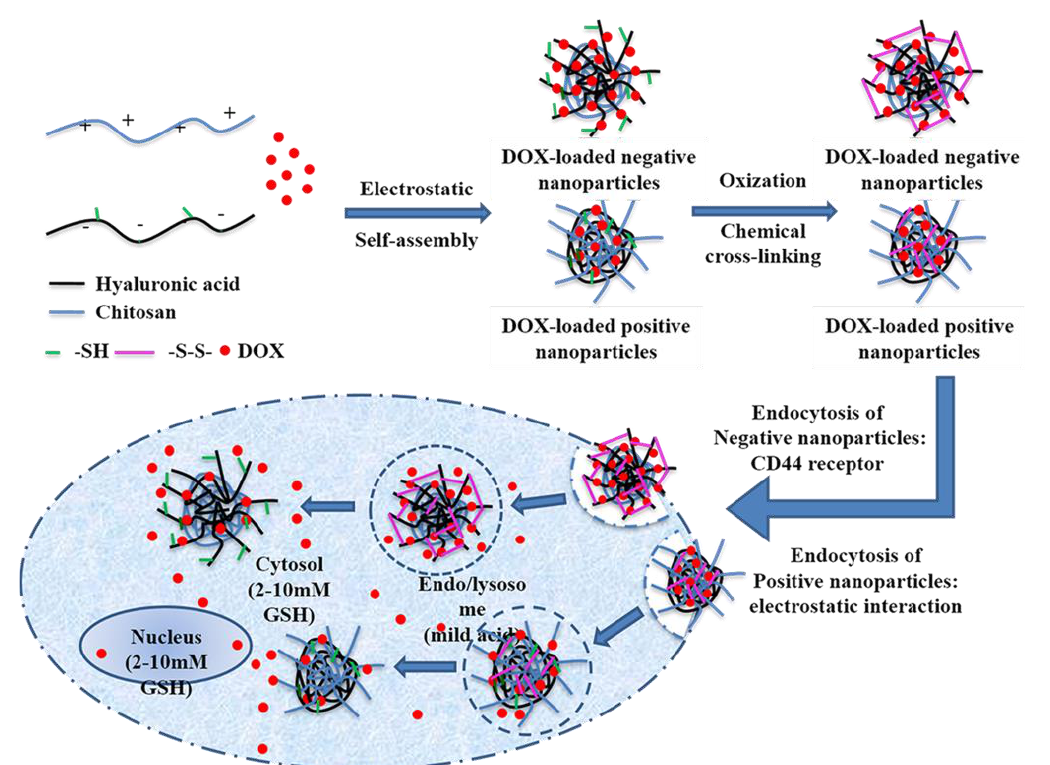
Scheme 1. Schematic illustration of preparation, redox and pH-sensitive drug release of HA – SH